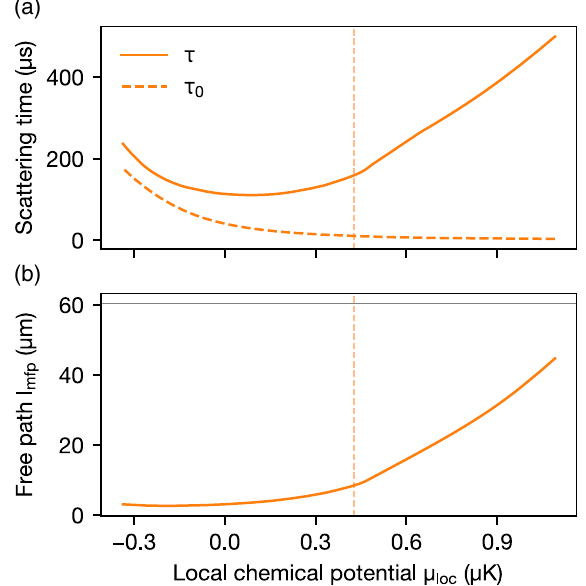
FIG. 7. Boltzmann approach for a homogeneous unitary Fermi gas at the channel center. (a) Interparticle scattering time in classical (dashed curve) and quantum (solid line) regimes and (b) mean free path versus local chemical potential. The horizontal line indicates the channel length 2 w in terms of the waist w of cy cy the laser beam which creates the channel. The superfluid transition (vertical dashed line) is estimated in Appendix B 4. The predictions are valid in the normal regime above the critical region. In the critical region, we expect the real values to be lower (see text), and in the superfluid regime, the theory